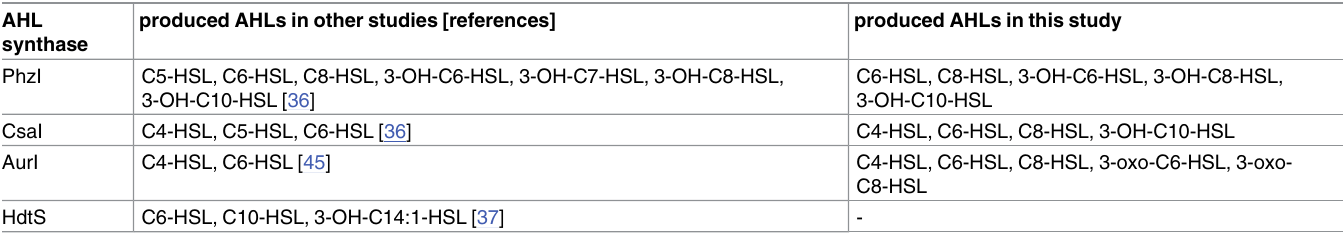
Table 2. Comparison of AHLs produced in different studies by different AHL